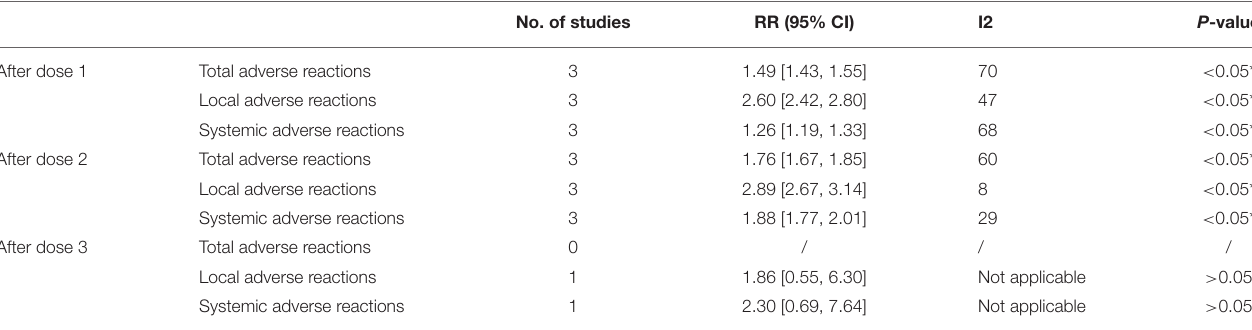
TABLE 3 | Total adverse reactions in vaccination group vs. control